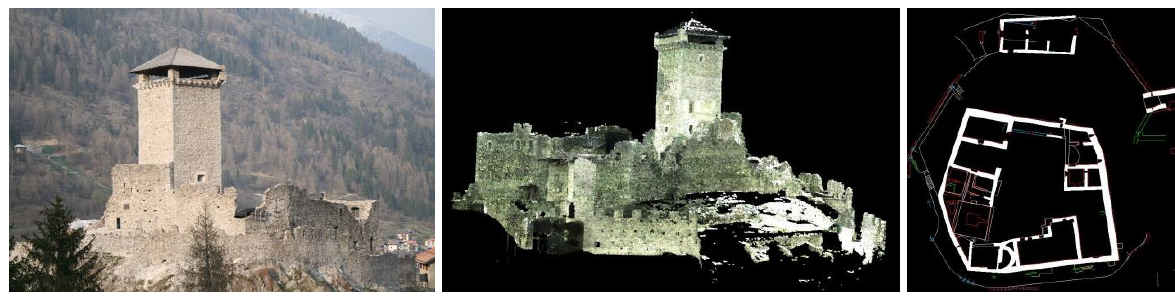
Figure 11. Range-based surveying of a medieval castle with TOF terrestrial laser scanning for detailed map production.